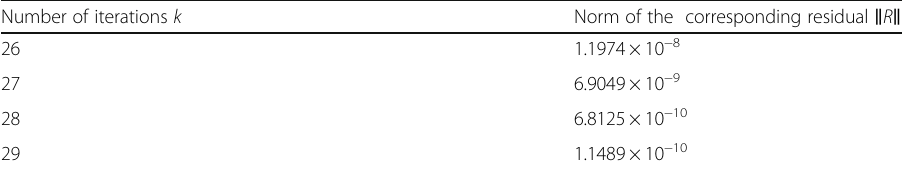
Table 1 The number of iterations and norm of the corresponding residual for the reflexive solution of the generalized Sylvester matrix equation Example